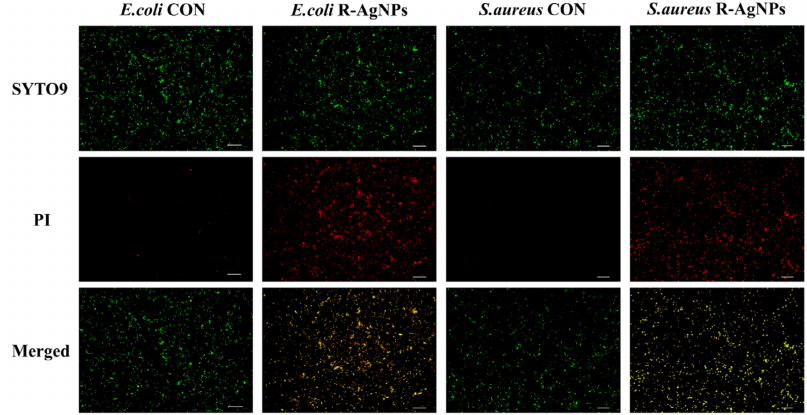
Figure 9. Fluorescence imaging of E. coli and S. aureus by R-AgNPs (2 MIC). Experimental conditions: 60 × oil microscope observation. The scale is 100 µ m.